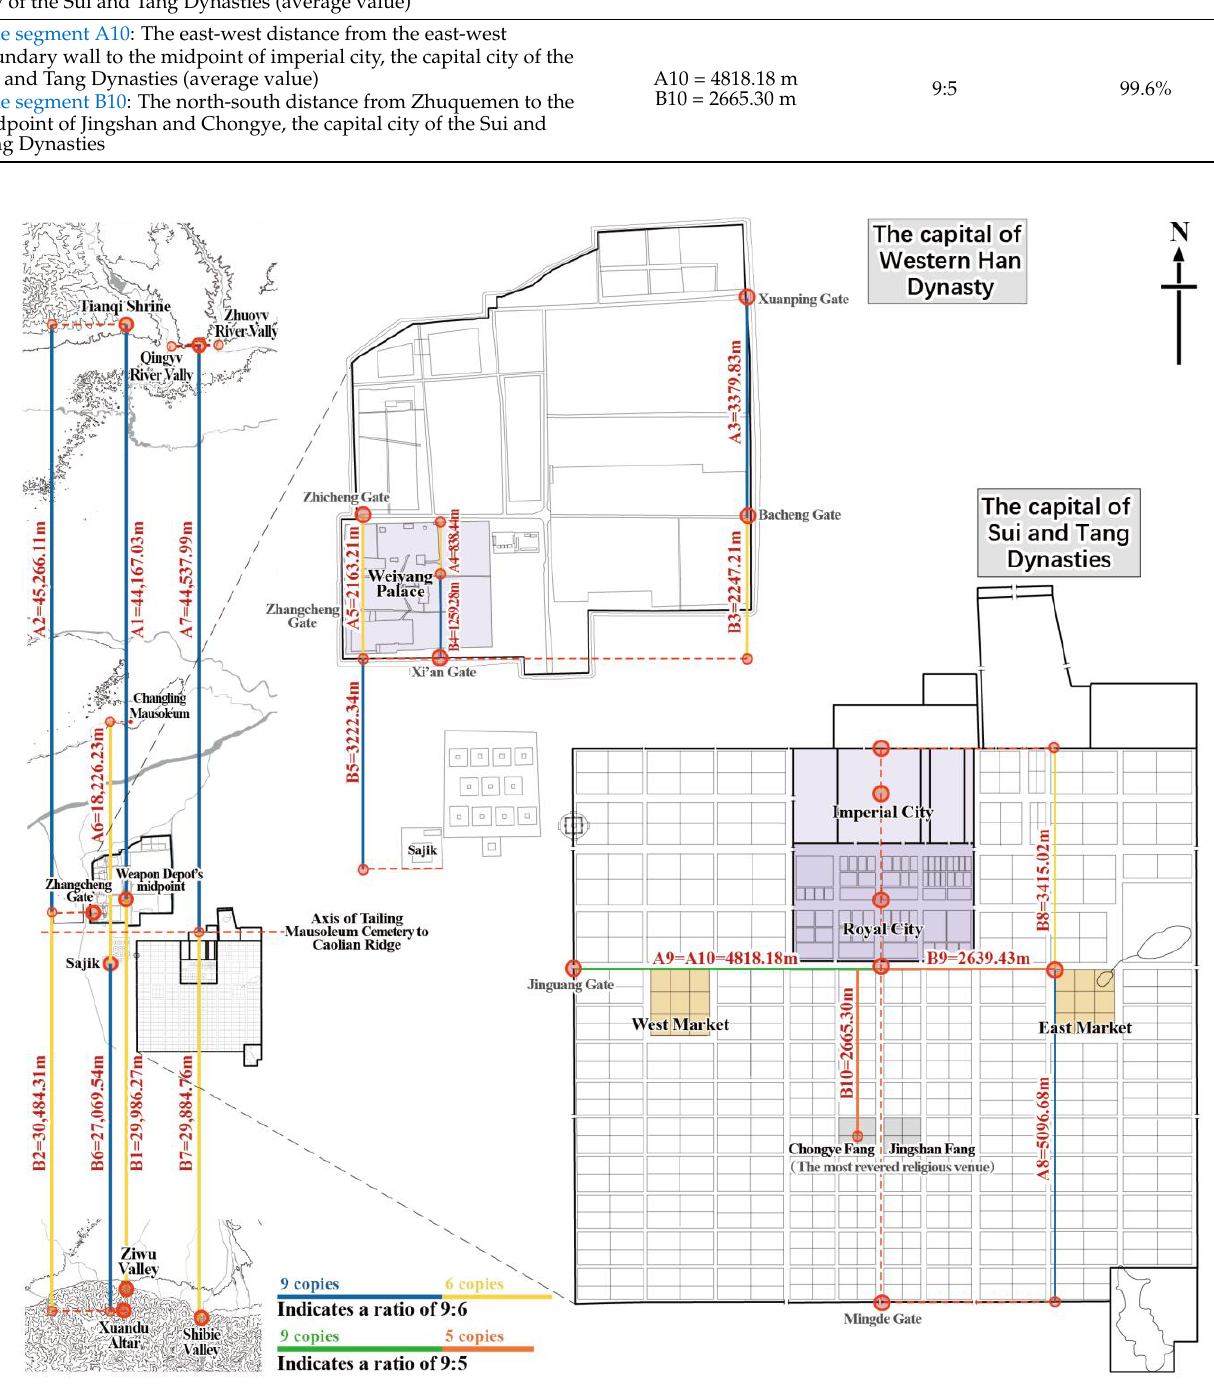
Figure 9. Proportion analysis chart of the capitals of the Western Han dynasty as well as the Sui and Tang dynasties.